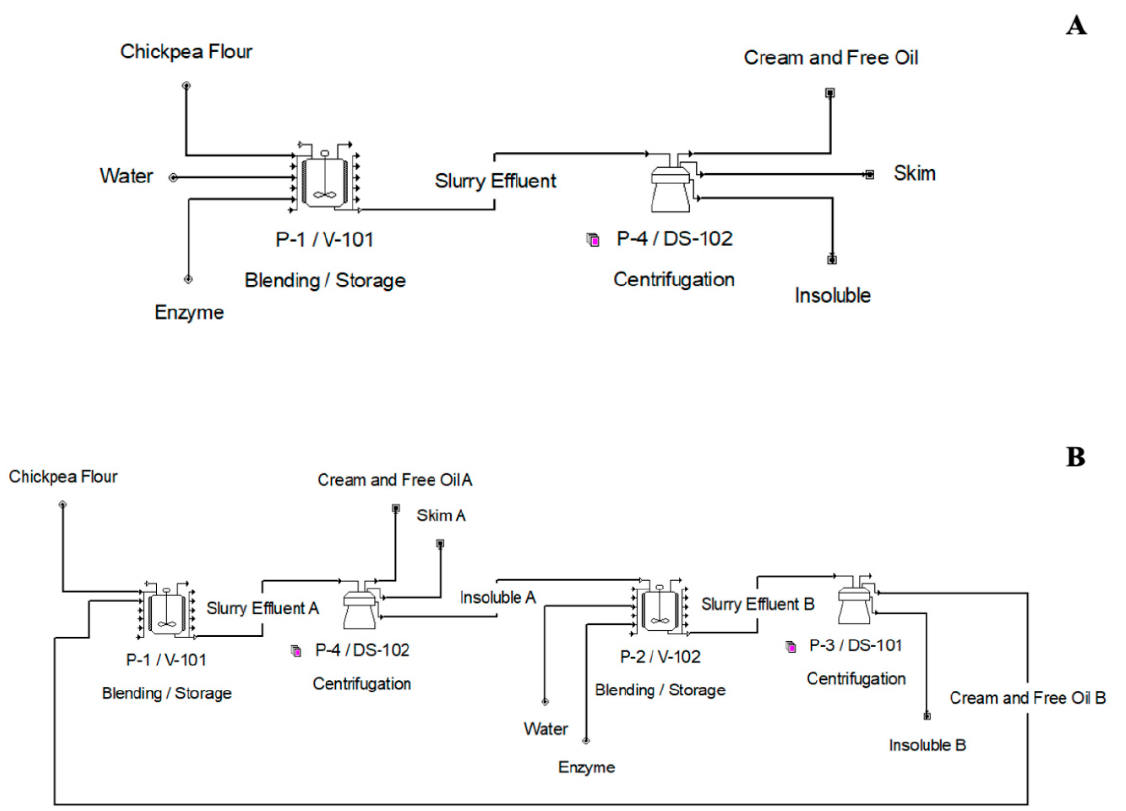
Figure 6. Modeling the techno-economic analysis of single-stage EAEP ( A ) and two-stage countercurrent EAEP ( B ) of chickpea full-fat flour. Table 2. Price points, early production and consumption, yearly revenue and operating costs, and total net gross profit of single-stage EAEP and two-stage countercurrent EAEP of chickpea full-fat flour.